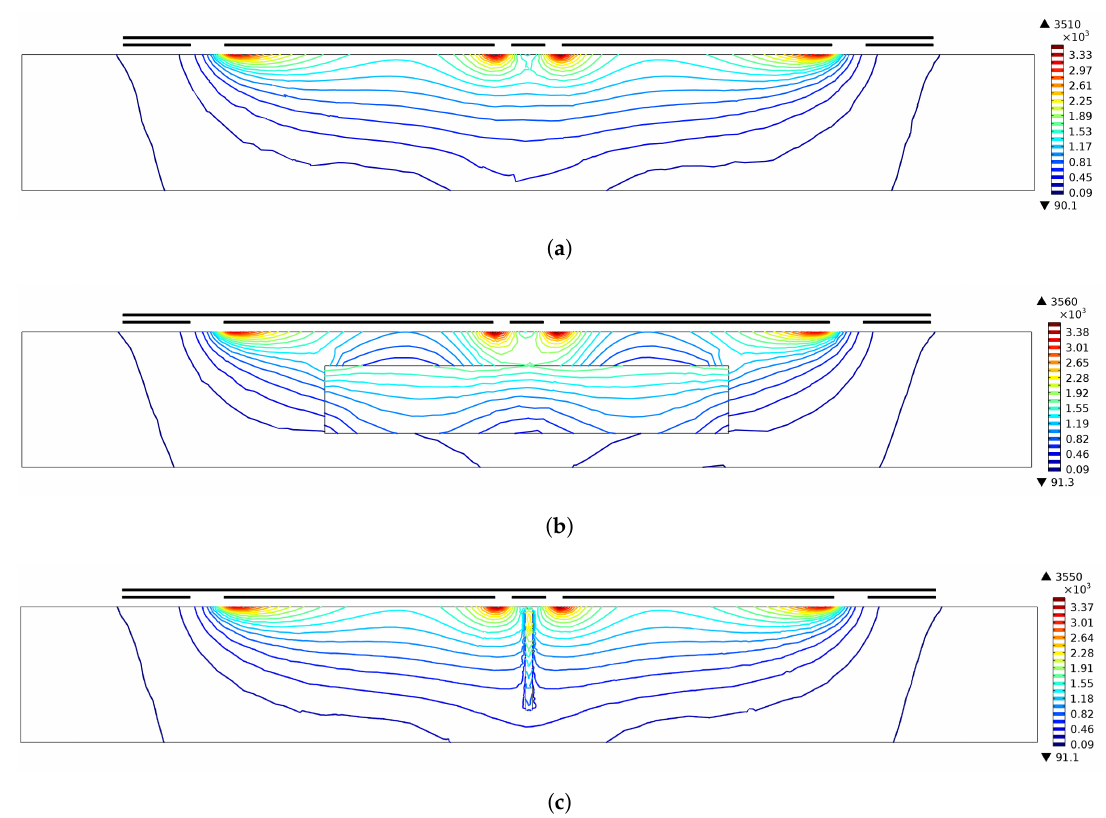
Figure 6. Simulations of the electric field distribution (V/m) for a sample in y = 0 plane: ( a ) no defect, ( b ) void under the surface, and ( c ) a sample with a narrow crack on the